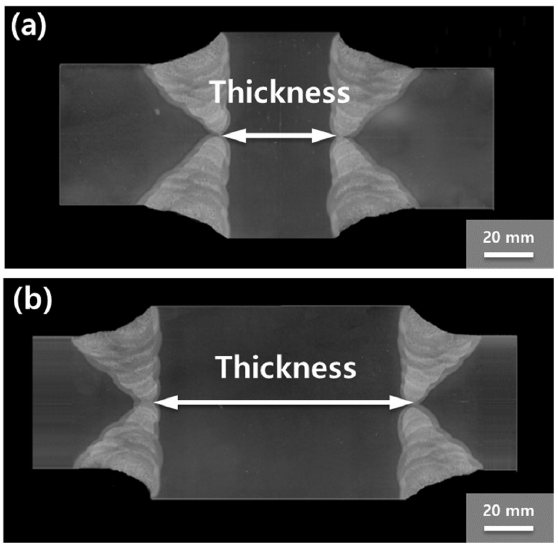
Figure 12. Window test results: ( a ) the 30 mm thick plate; ( b ) the 70 mm thick plate.